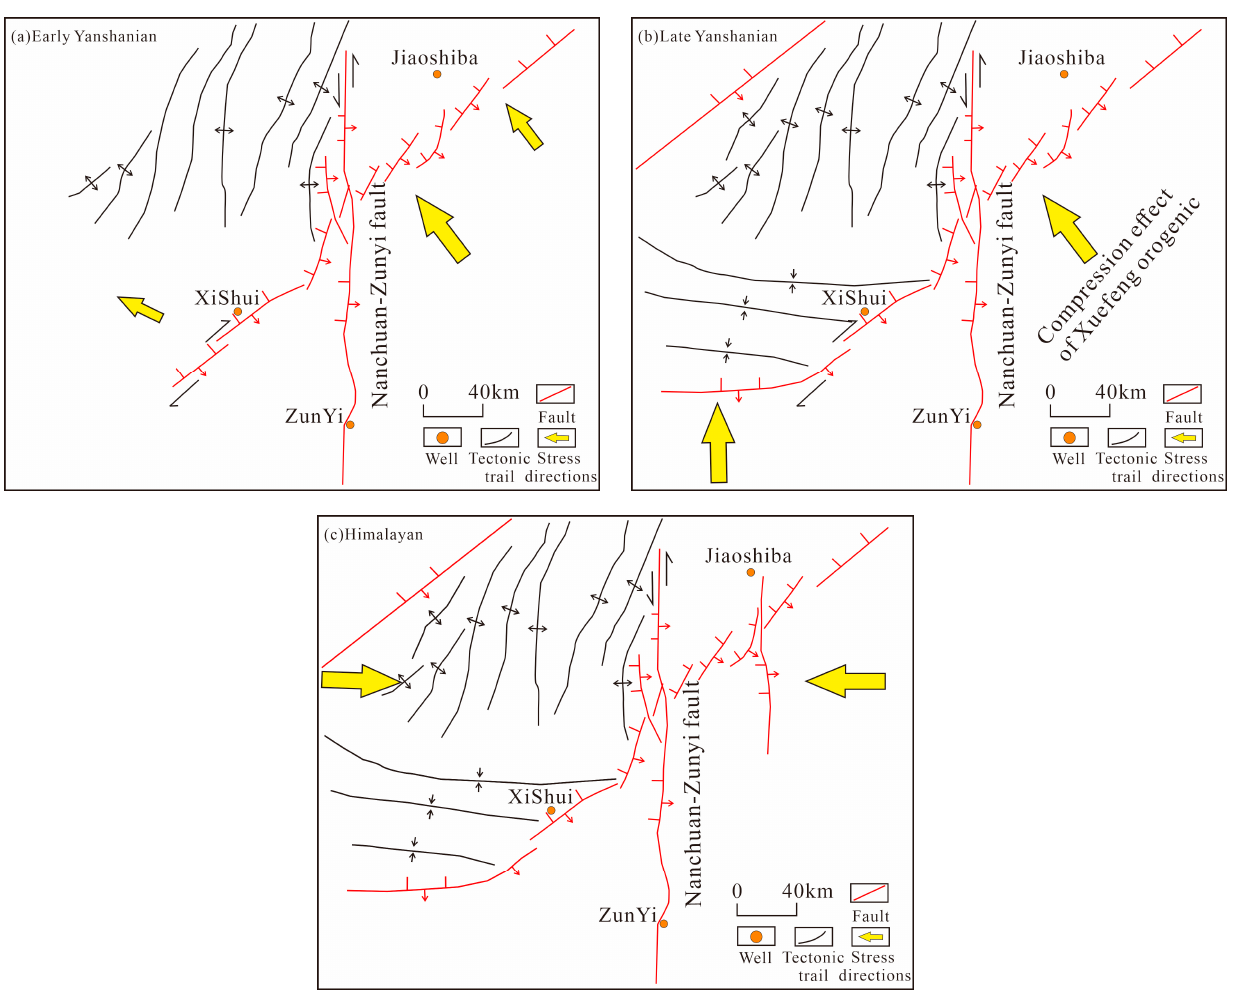
Figure 5. The distribution characteristics of faults in different periods. ( a ) Distribution of the early Yanshanian fault; ( b ) distribution of late Yanshanian fault; ( c ) distribution of late Himalayan fault.